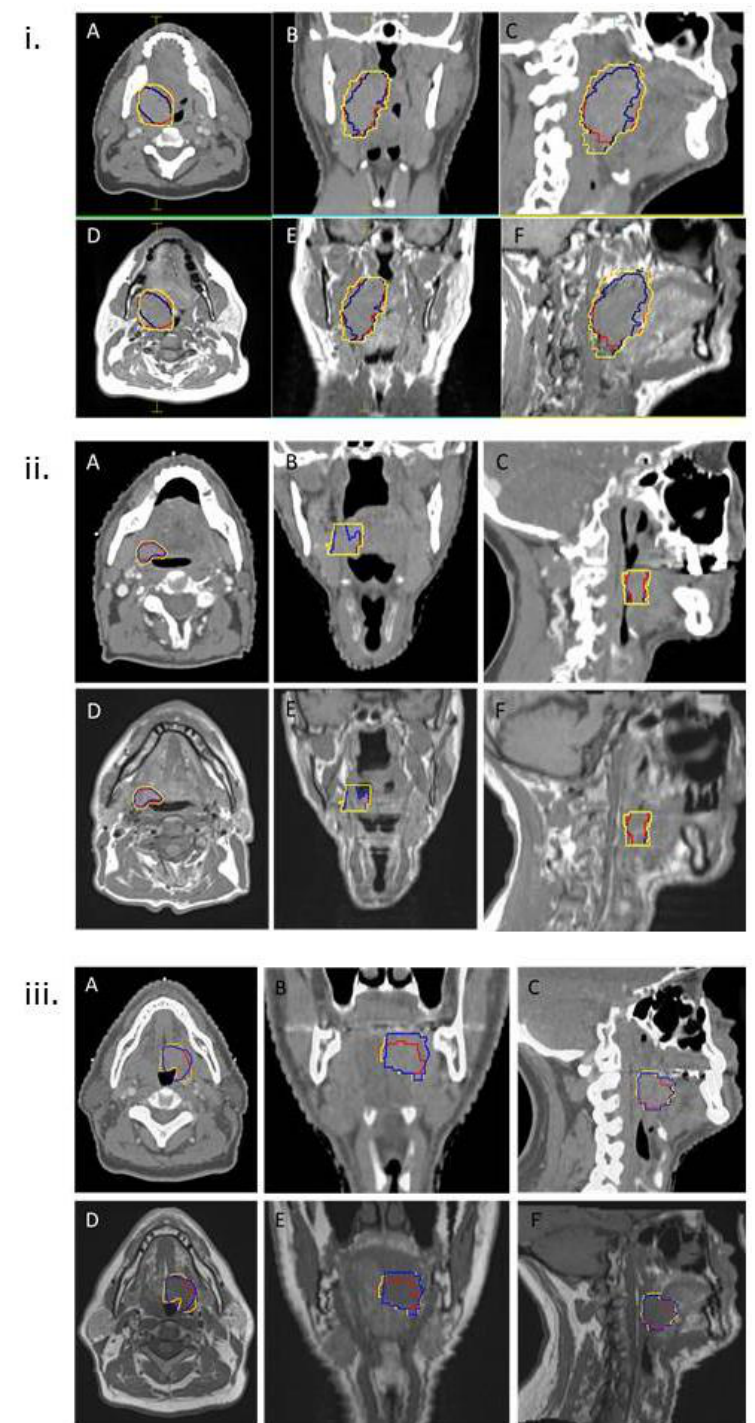
Figure 1. Examples of delineation of primary tumour GTV using CT and deformably coregistered MRI in patients with different size primary tumours. (i) Example of large primary right tonsil carcinoma T3N2bM0 (Patient 1 in Table 1). (ii) Example of small primary right base of tongue carcinoma T1N2bM0 (Patient 20 in Table 1). (iii) Example of medium sized primary base of tongue carcinoma T4aN2bM0 (Patient 6 in Table 1). GTV CT (red), GTV MR (blue) and GTV CTMR (yellow) are shown. For each patient in (i), (ii), and (iii) axial, coronal, and sagittal images of planning CT are shown in ( A ), ( B ), and ( C ) respectively; ( D ), ( E ), and ( F ) show axial, coronal, and sagittal images of deformably coregistered T1-weighted diagnostic MRI respectively.